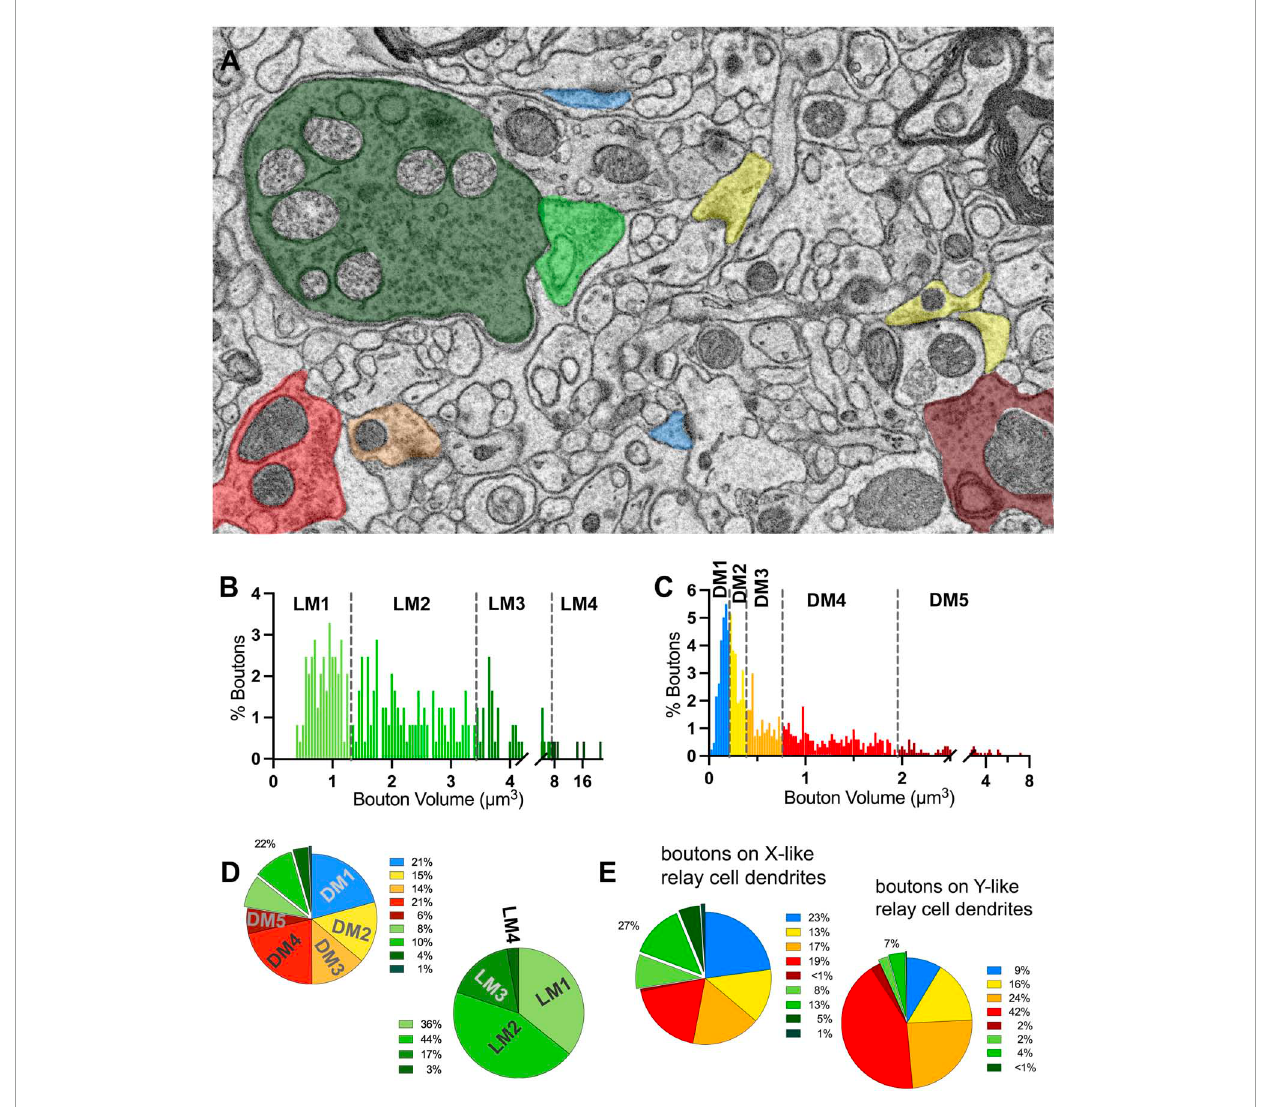
FIGURE5 Volume sorting of boutons synapsing on relay dendrite segments. (A) The cutoff values obtained in the UTS analysis are applied to terminal boutons that synapse on relay cells. Boutons are pseudocolored for subpopulations, same as in Figure 1 , except for mitochondria to illustrate the light- or dark-contrast morphological criteria used for initial sorting of LM and DM boutons. (B,C) The frequency distribution of LM (B) and DNM (C) boutons reveal multimodal distributions for each group sorted by the morphological criterion for mitochondria appearance. The UTS cutoff values (dashed lines) distinguished four subpopulations for LM and five subpopulations for DNM groups. (D) Contribution of nine subpopulations of boutons synapsing on relay dendrites. Retinal boutons constituted 22% of all synapses, while ∼ 40% of synapses (top pie chart) are from two subpopulations with the smallest bouton sizes (presumed cortical and brainstem inputs). Among the retinal boutons (bottom pie chart), the two largest-sized boutons constitute 20% of all retinal boutons and 5% of all boutons. (E) Dendrites that display spines or grape-like appendages (top pie chart)